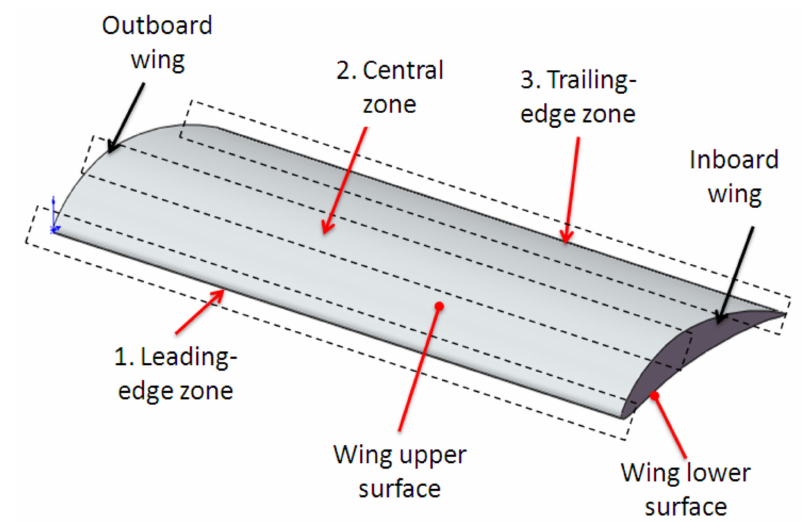
Figure 4. The long-span wing model.